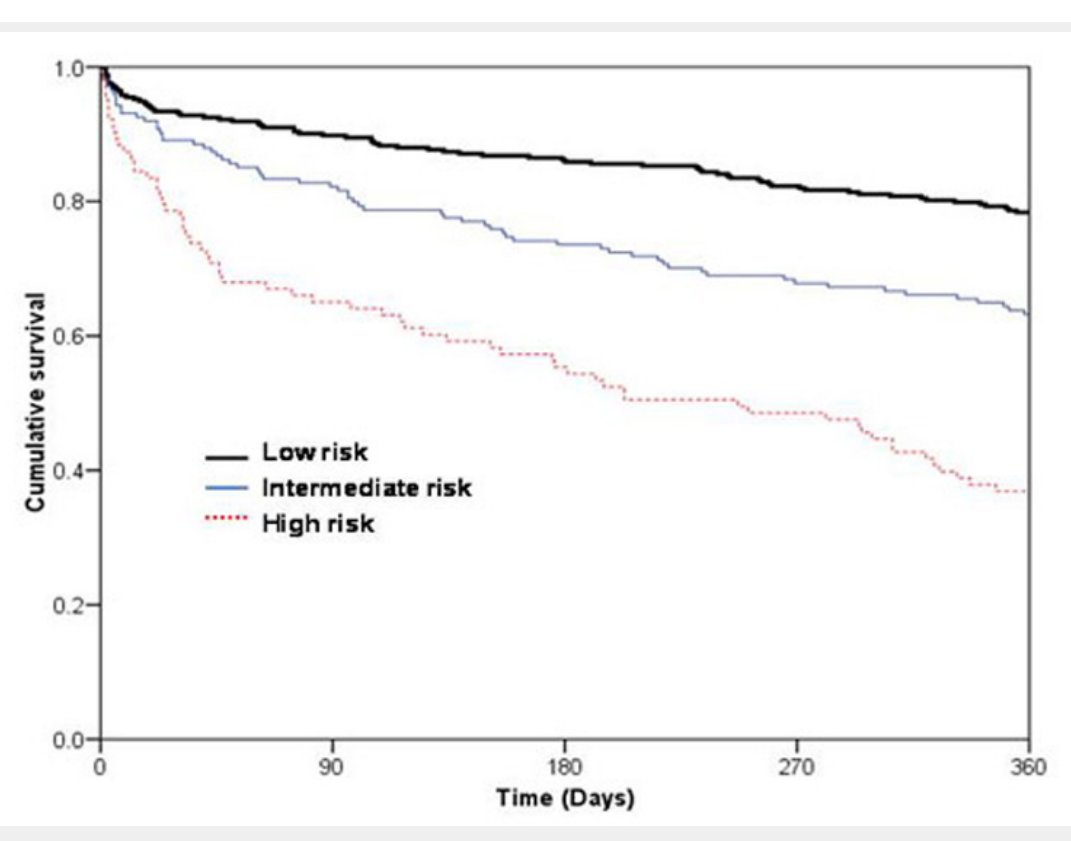
Figure 3 Kaplan-Meier curves demonstrating cumulative survival in patients with ADHF over time according to risk groups: 1) high risk (BUN ≤;27.5 mg/dl and age >86 years), 2) intermediate risk (BUN ≤27.5 mg/dl and age £86 years) and 3) low risk (BUN ≤;27.5 mg/dl); p <0.001 by